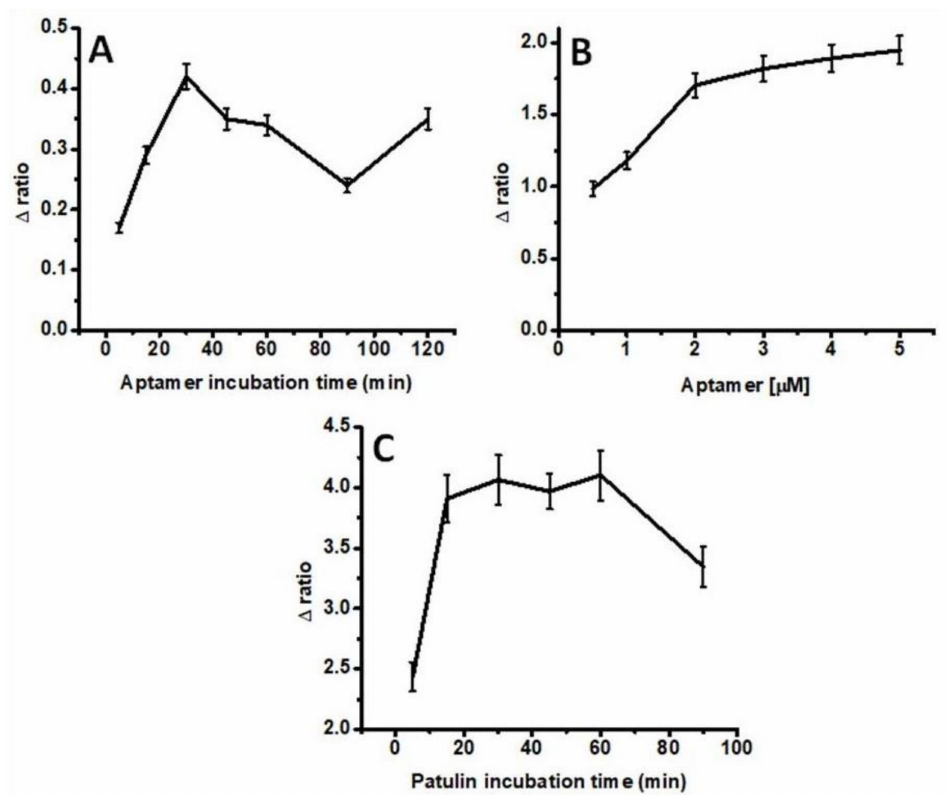
Figure 2. Optimization of experimental parameters. ( A ) Variation in ∆ ratio with increasing time after incubation with aptamer solution. ( B ) Variation in ∆ ratio with varying aptamer concentration. ( C ) Variation in ∆ ratio obtained at different intervals of time after the incubation of